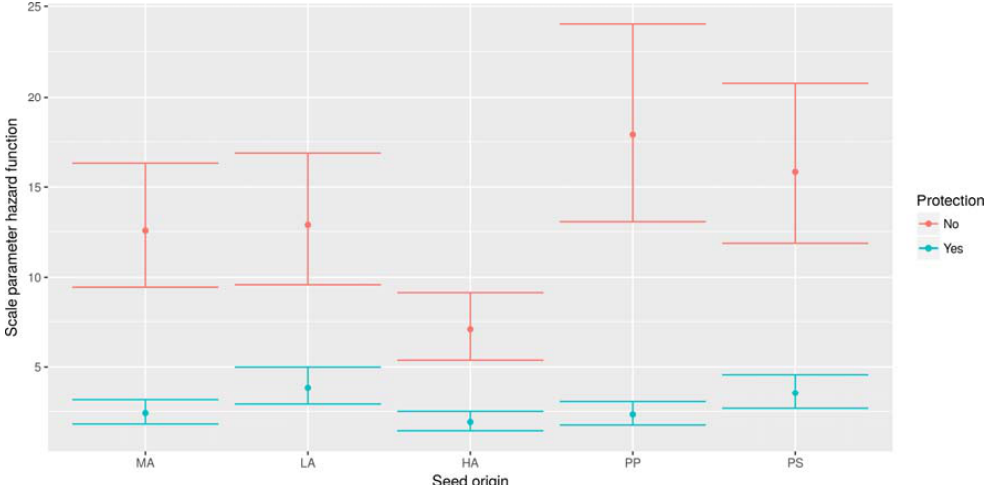
Figure 5. Scale parameter of the hazard function for each combination of seed origin (MA: P. nigra from typical distribution, HA: P. nigra from upland forests distribution, LA: P. nigra from lowland forests distribution, PS: P. sylvestris and PP: P. pinaster ) and protection. The error bars indicate the 95% credible interval.